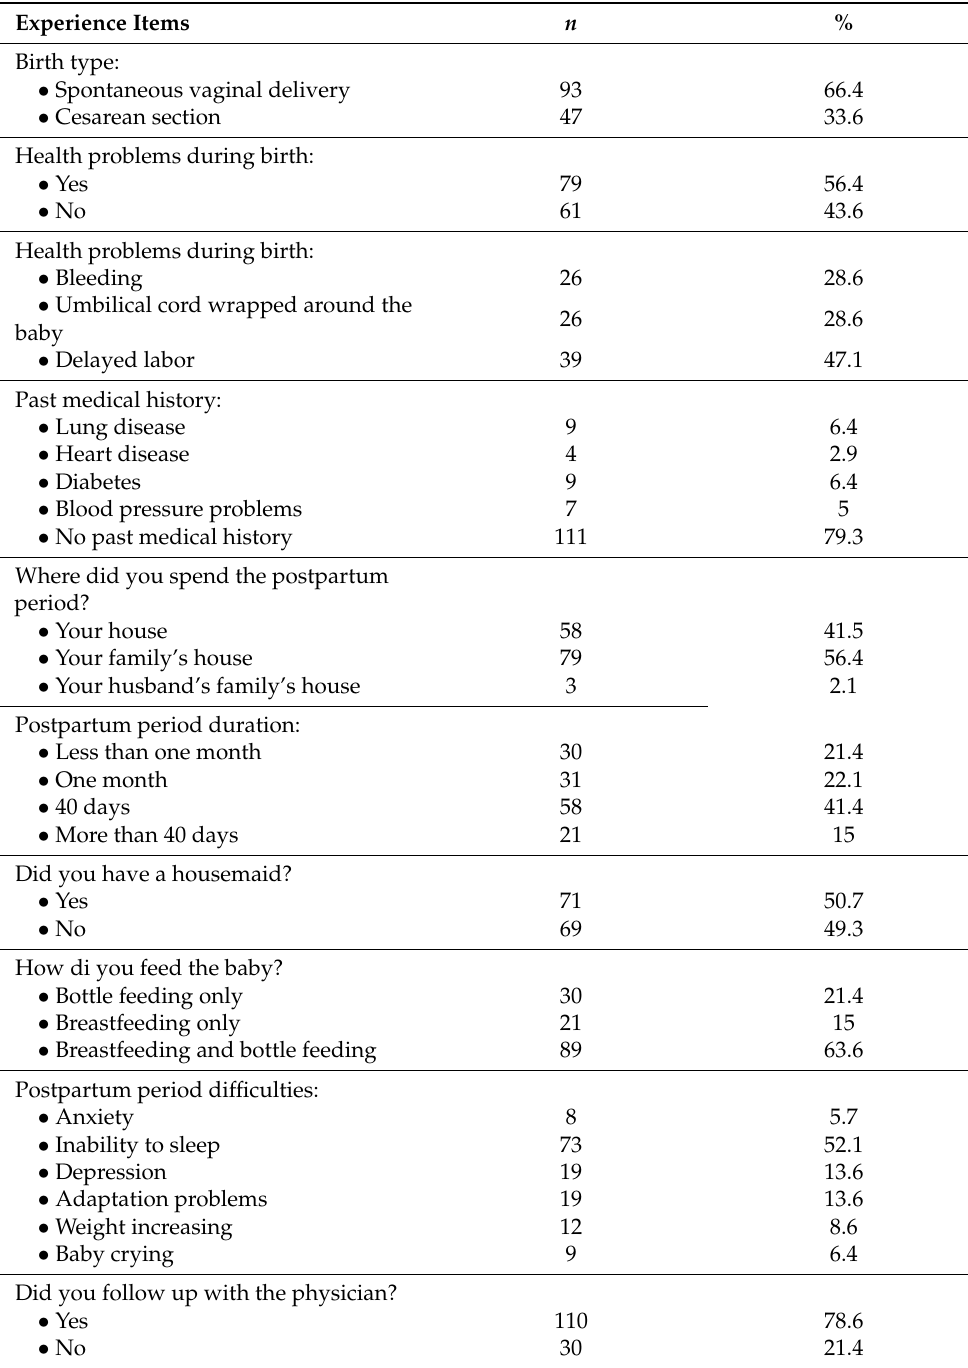
Table 3. Postpartum experiences for the new